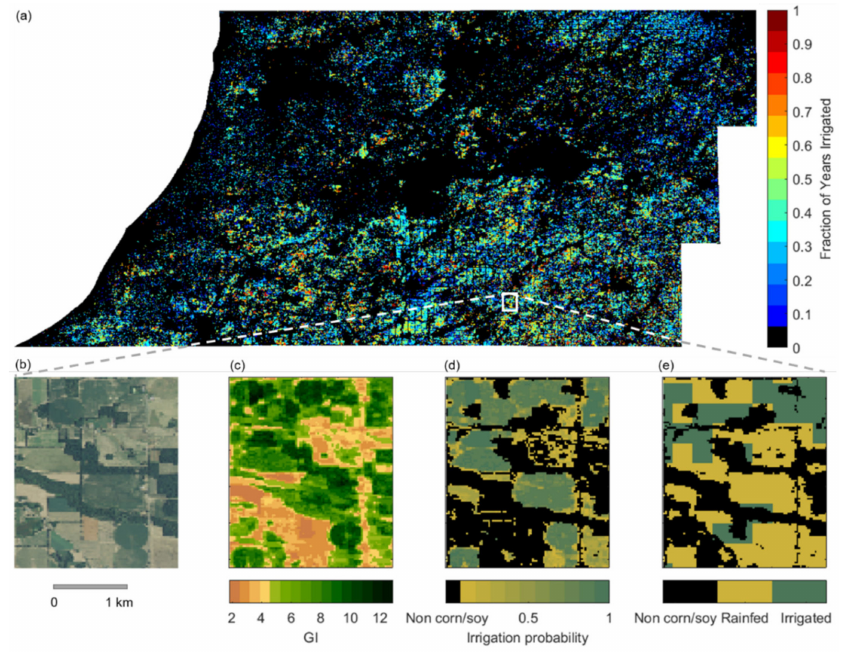
Figure 3. ( a ) Map of fraction of years classified as irrigated since earliest year irrigated according to the fandom forest (RF)-based annual irrigation maps spanning 2001–2016. For example, a pixel that is irrigated every year since the start of irrigation in 2012 will receive a fraction of 1.0. 2012 insets of ( b ) NAIP aerial image showing irrigated farms with varying sizes, ( c ) GI calculated from the Landsat scene that immediately follows the largest dryspell (GI_ppt), ( d ) random forest-based irrigation probability map with 30-m resolution and ( e ) MIrAD-US irrigation map with 250-m resolution. Images ( b – e ) are for 2012. Areas not classified as corn or soybeans (USDA-NASS, 2016) are shown in